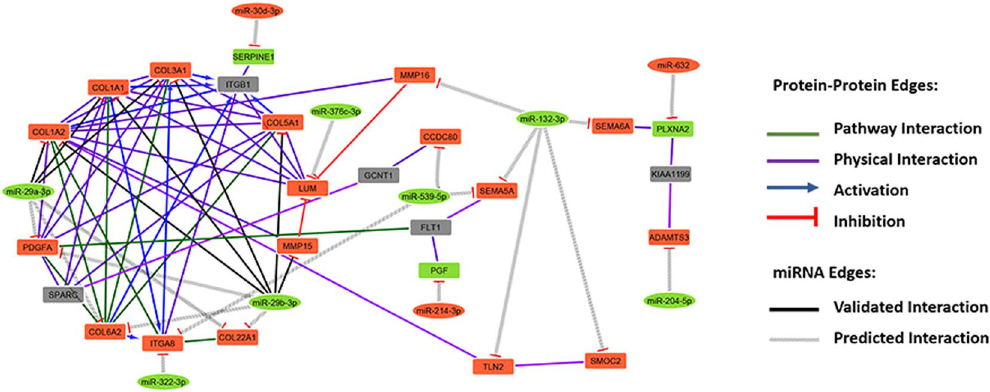
Figure 6. Complexity of the miRNA-mRNA interactome network in rat soleus muscles with cardiac cachexia. The regulatory network displays predicted and validated interactions between miRNAs (rectangle) and mRNAs (elliptic) deregulated from TLDA and microarray experiments generated by using a fold-change cutoff < 1.5, P < 0.05 and enrichment with physical and pathway protein-protein interaction by Cytoscape